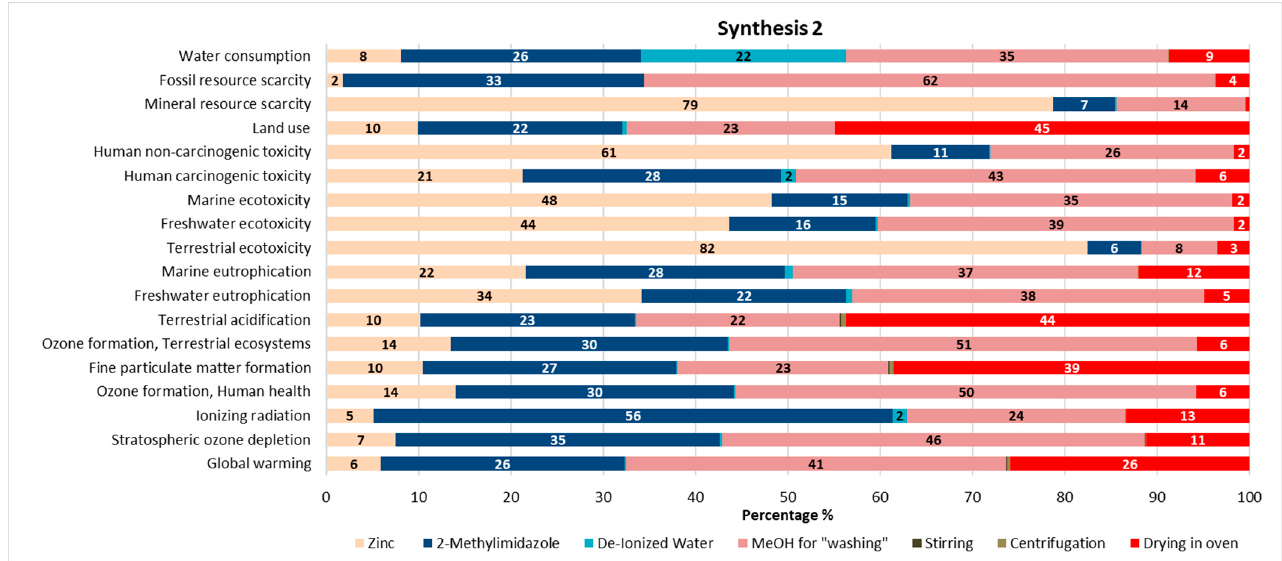
Figure 5. Life Cycle Assessment of the 2nd synthetic approach of ZIF-8. Method: ReCiPe 2016, midpoint (H) V.1.01.